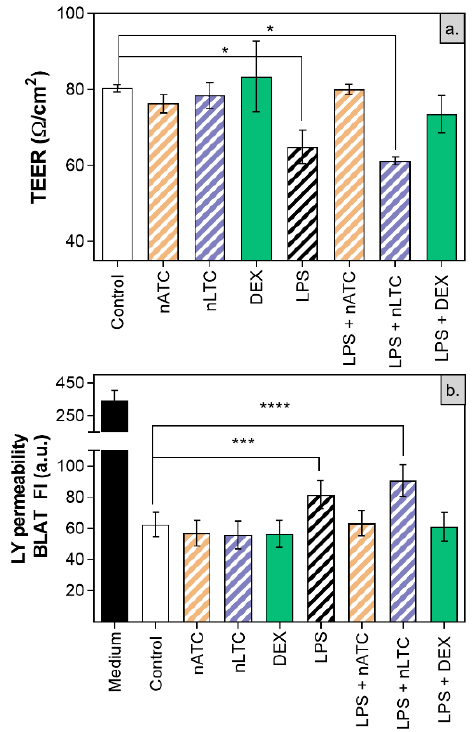
Figure 11. ( a ) TEER and ( b ) LY permeability after CUR nanovesicles were nebulized on the liquid-air interface of an A549 cells monolayer as an in vitro model of pulmonary alveoli. Values were analysed using a one-way ANOVA compared with control, * p < 0.05; *** p < 0.001, **** p < 0.0001.